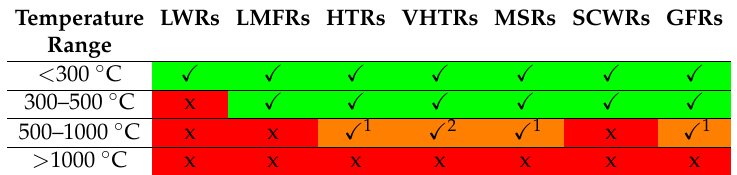
Fast Reactors (GFRs) capable of operating in the associated temperature ranges